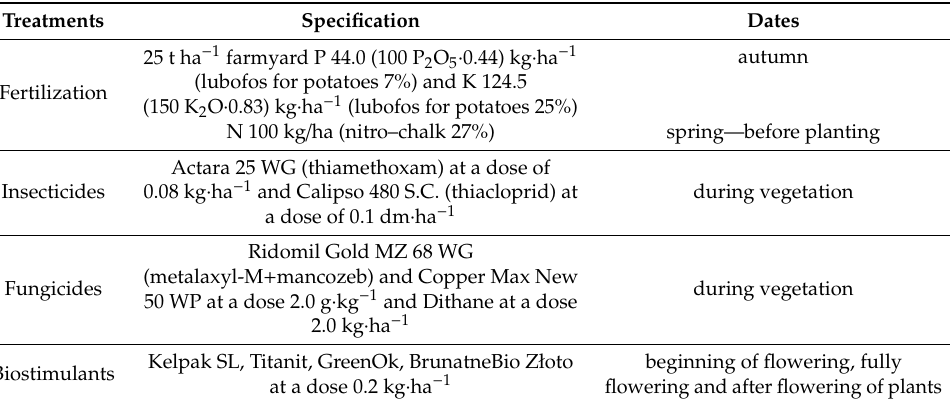
Table 3. Cultivation and care